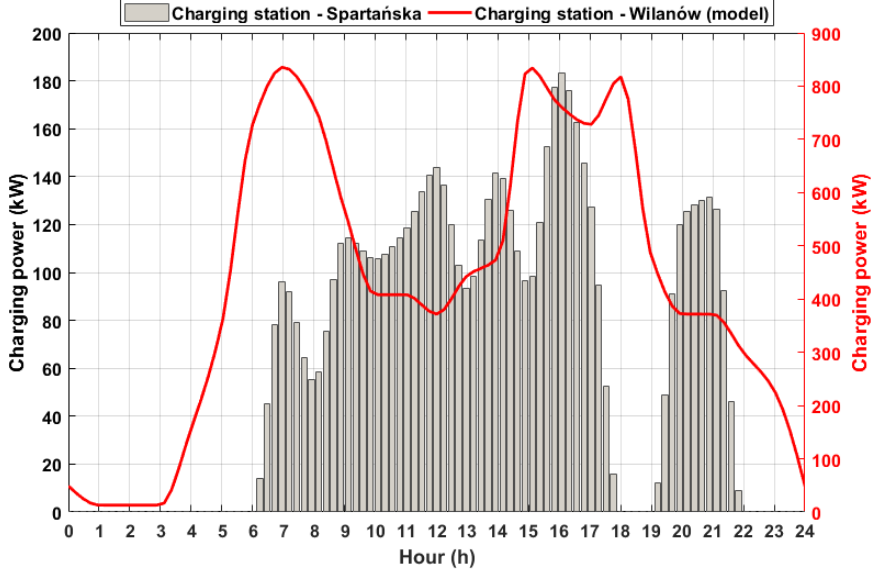
Figure 4. Daily power demand curve of charging points for electric buses.